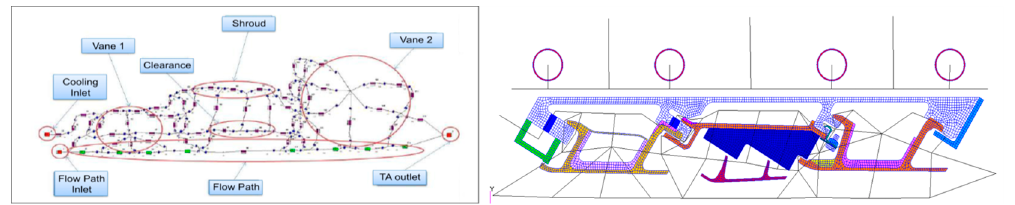
Figure 13. Fluid network ( left ) and thermal network ( right ).